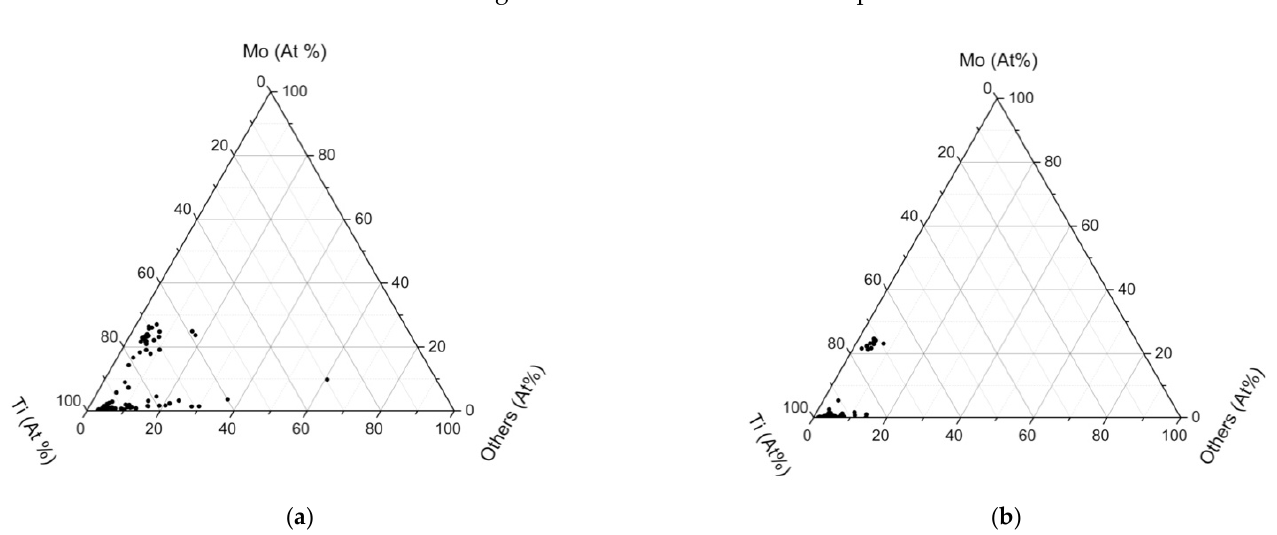
Figure 6. Micrographs of MX in different heat-treated samples.